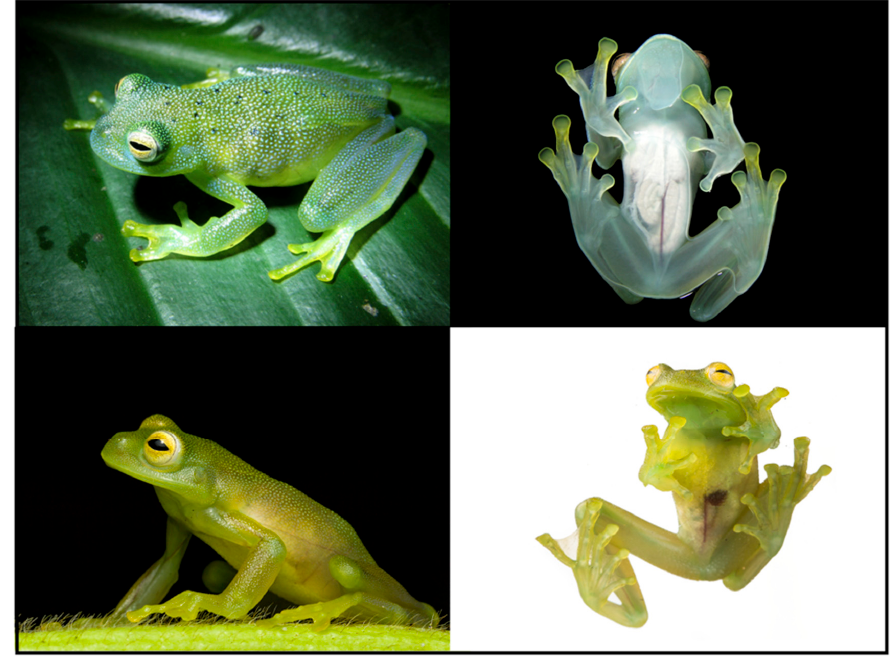
Figure 67. Cochranella granulosa in life. Top row : Reserva Guayacán, Costa Rica; photos by Brian Kubicki. Bottom row : Reserva El Jardín de los Sueños, 461 m, Cotopaxi province, Ecuador, MZUTI Kubicki. ( Bottom row ): Reserva El Jard í n de los Sueños, 461 m, Cotopaxi province, Ecuador, MZUTI 4811; photos by Jaime Culebras (dorsolateral) and Javier Aznar (ventral). 4811; photos by Jaime Culebras (dorsolateral) and Javier Aznar